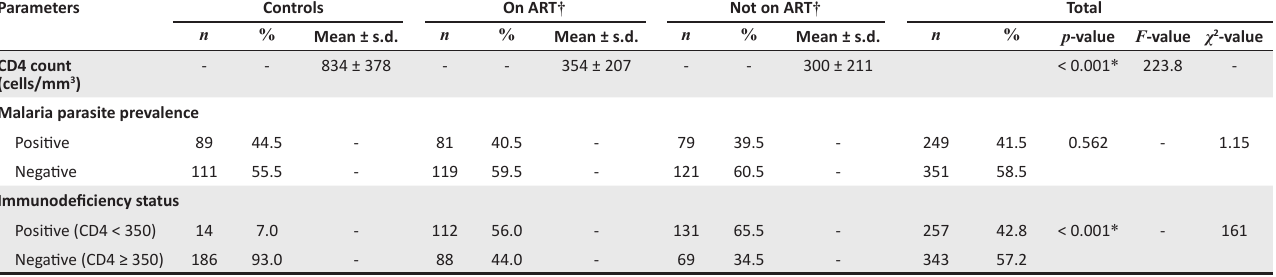
TABLE 2: Prevalence of malaria and immunodeficiency status among controls and HIV-positive patients with and without antiretroviral therapy, Abuja, Nigeria in 2012–2013.